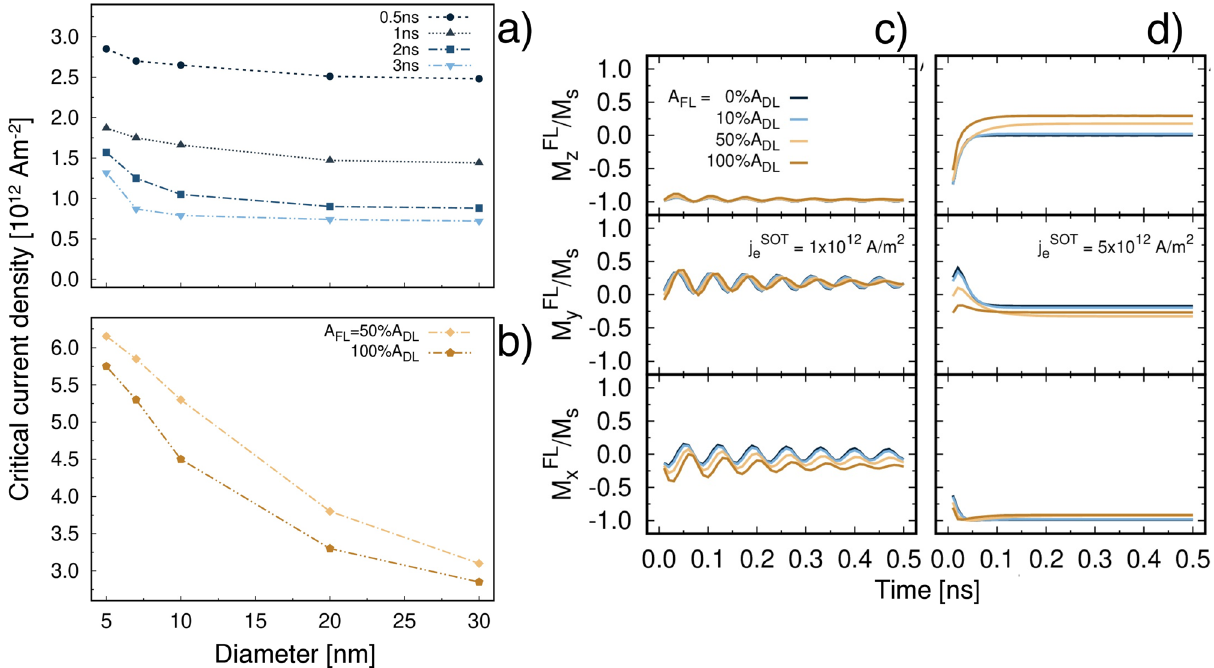
Figure 3. ( a ) Plot of the critical current density for STT switching j STT c as a function of MTJ diameter for different pulse widths. ( b ) Plot of the critical current density for SOT switching j SOT c as a function of different strengths of the SOT field-like component ( A F ) with respect to the damping-like term ( A D ). For A F = 0% and 10% j SOT c could not be determined. Time evolution of the magnetisation components of a 20 nm diameter MTJ as a function of A F for j SOT